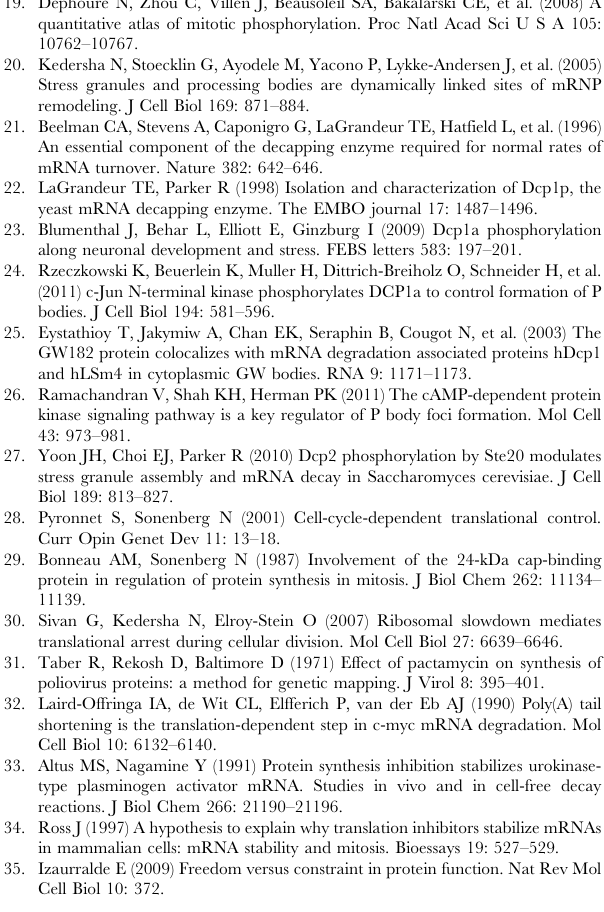
reduction in the molecular weight of hDcp1a, compared to untreated, G1/S blocked (Thy), and metaphase blocked cells (Noc), and the appearance of slower migrating Dcp1a bands. This demonstrated that Dcp1a is hyper-phosphorylated during mitosis. Treatment with cycloheximide (Cyclo) for 1 or 4 hrs did not change the mobility of hDcp1a indicating that hyper-phosporyla- tion is cell cycle dependent. (B) Shift in mobility due to hyper- phosphorylation in mitotic cells is seen also for GFP-Dcp1a and GFP-Dcp1b using an anti-GFP antibody. Phosphatase (Noc + P- Pase) treatment caused a reduction in the molecular weight of GFP-Dcp1a and Dcp1b, compared to control. Tubulin was used as a loading control. (TIF) Figure S2 Putative phosphorylation sites in the hDcp1a protein. The central region of Dcp1a is marked in red (200–380, as used in figure 5). Serine, threonine, and tyrosine residues are marked in green. Mutated amino acids are marked in yellow. (TIF)